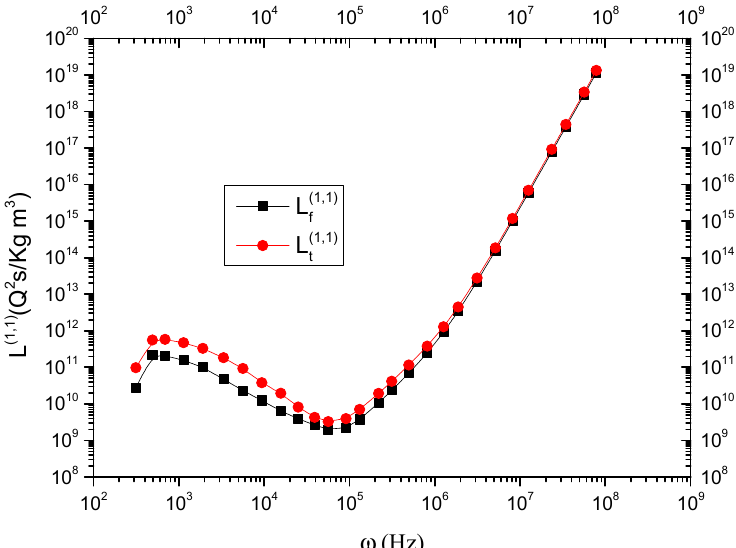
Figure 3. Comparison between normal (black line) and cancerous cells (red line) of displacement conductivity L (1,1) as a function of frequency, see Equation (A17).